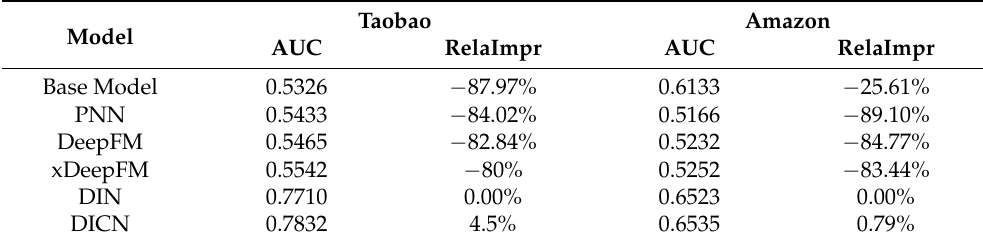
Table 2. AUC and RelaImpr predicted by